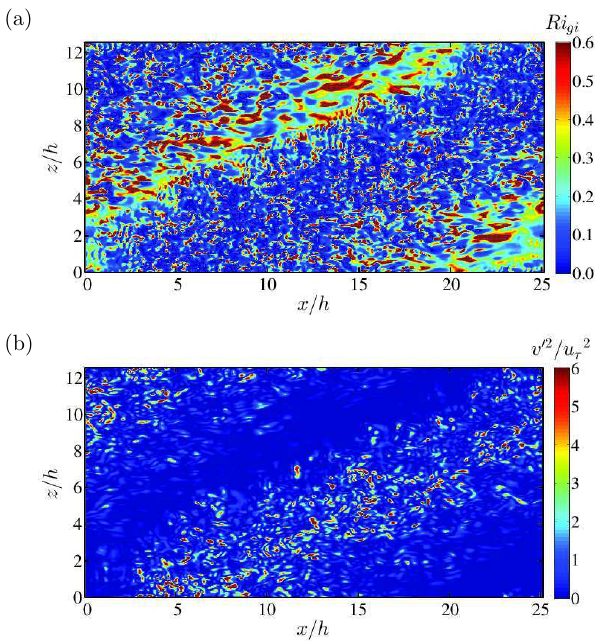
Figure 17. Instantaneous contour of (a) Ri gi and (b) v (cid:48) 2 at the hor- izontal plane with y + = 90 ( Re τ = 180, Ri τ = 120).